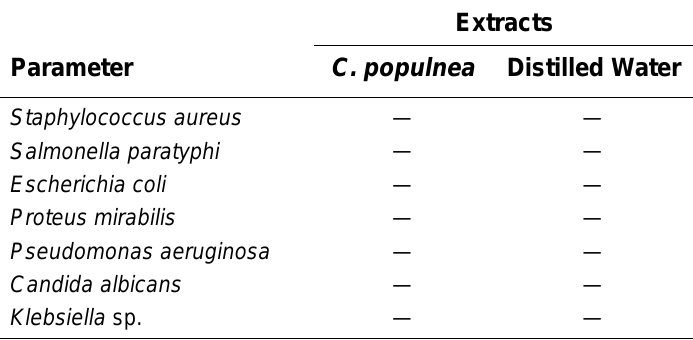
Antimicrobial Screening of C. populnea Extracts Against Some Selected Microorganisms Extracts Parameter C. populnea Distilled Water Staphylococcus aureus — — Salmonella